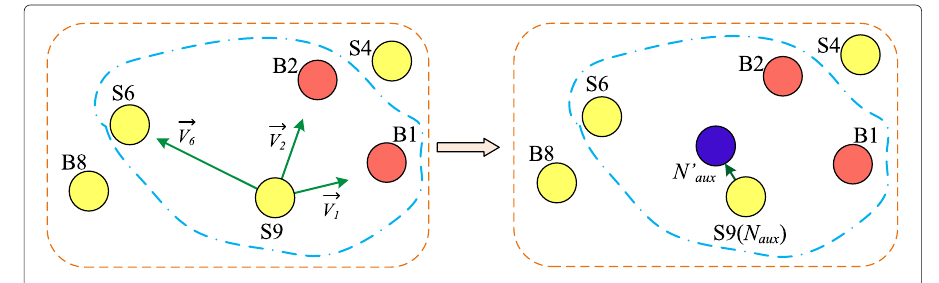
Fig. 5 Results of data position correction of the auxiliary node